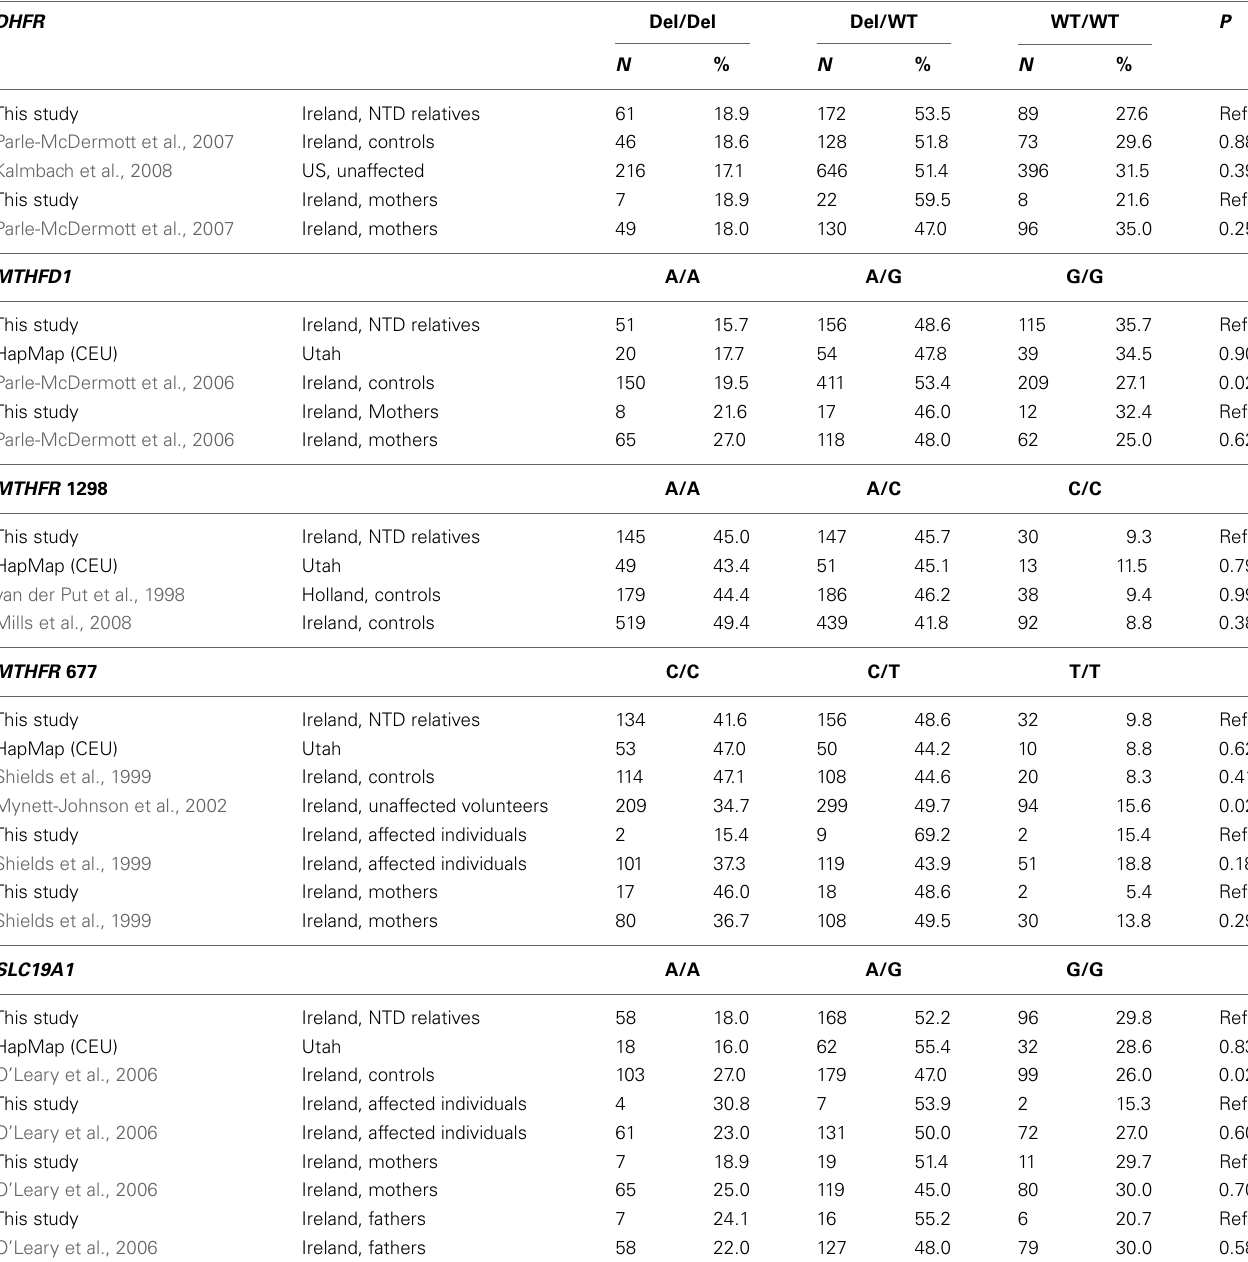
Table 3 | Distribution of genotypes and comparison with other